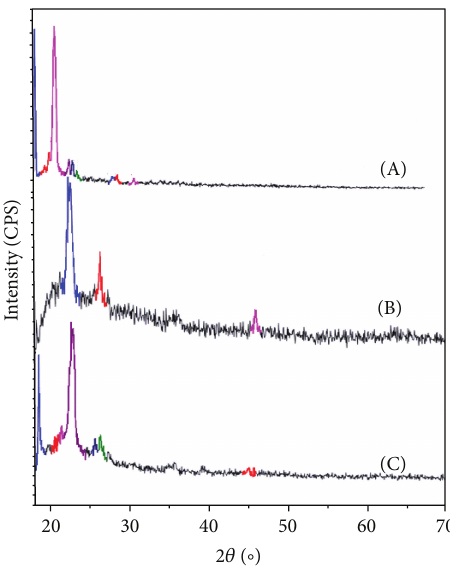
Figure 7: Combined XRD scans of PEO/CPMMT/Salt (PCS1) (2.1wt% A), PEO/CPMMT/Salt (PCS2) (3.5 wt% B), and PEO/ CPMMT/Salt (PCS3) (5 wt% C).